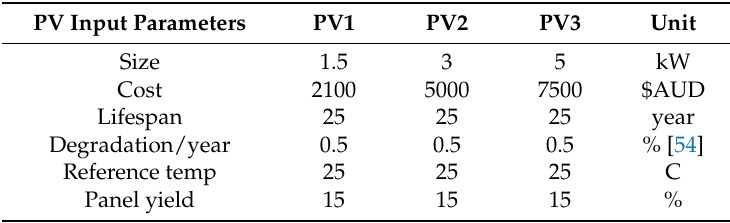
Table 3. PV system installed costs.